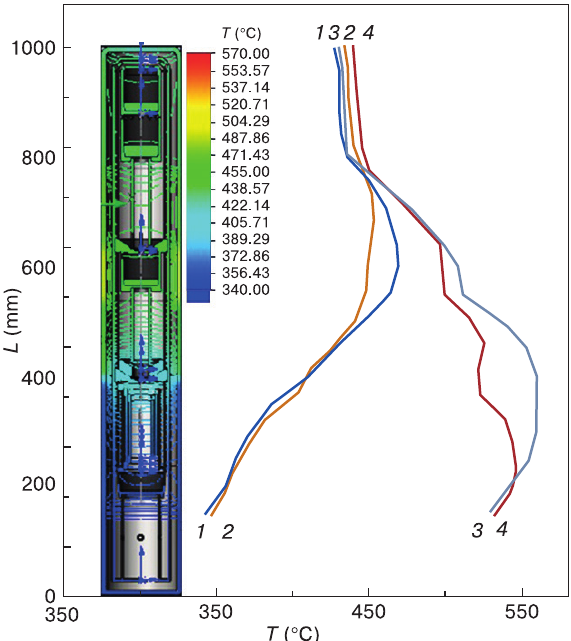
Figure 5. Temperature profile distribution in the reactor unit with material (Te) in vacuum during second distillation (left) and calculated axial temperature distribution in the reactor (right): ( 1 ) second distillation; ( 2 ) second distillation with tellu- rium; ( 3 ) second drain; ( 4 ) second drain with tellurium